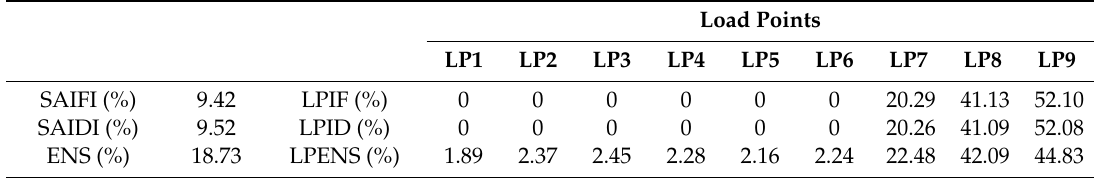
Table 7. Feeder and load point reliability indices improvement for Case-3.